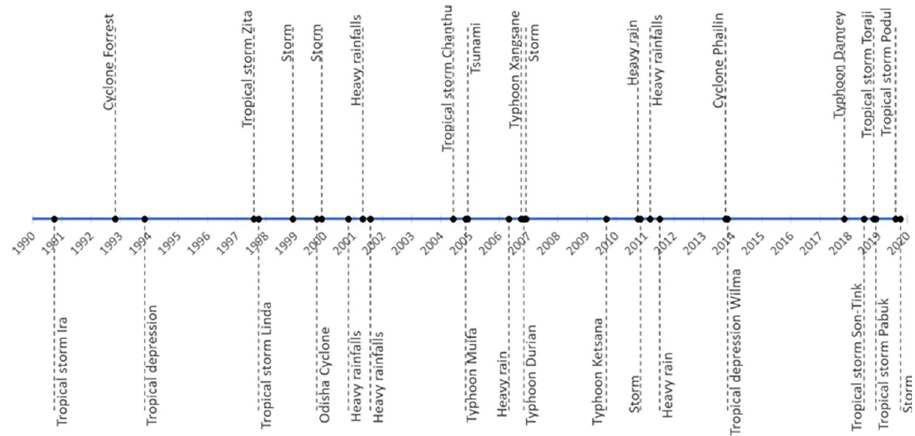
Fig 2. Extreme weather inventory. Data derived from on a conglomerate of news reports and the IBTrACTS data available on the National Oceanic and Atmospheric Administration